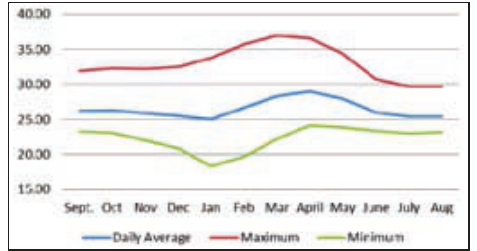
Fig. 1. Monthly mean ambient temperature of